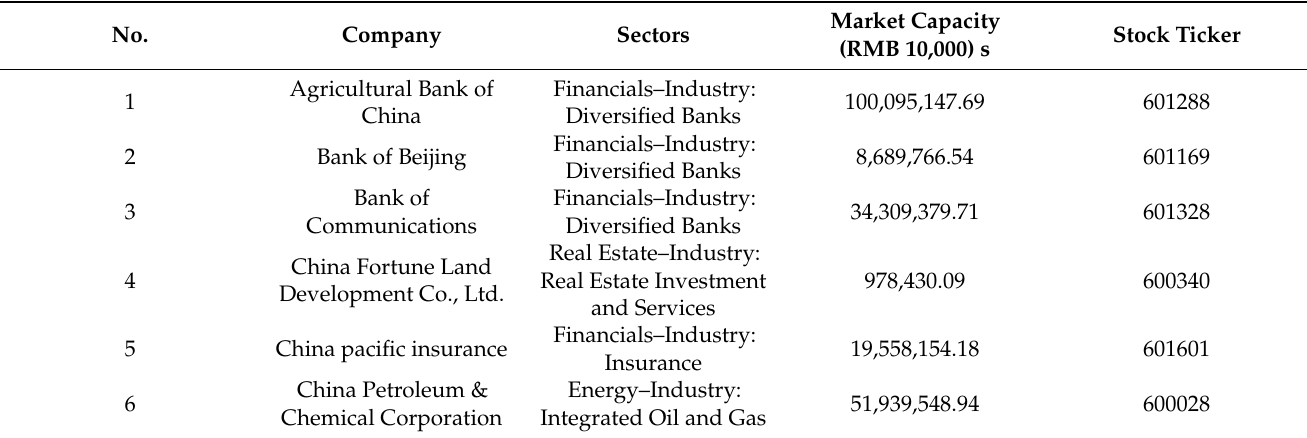
Table 2. Six companies selected from SSE [151].